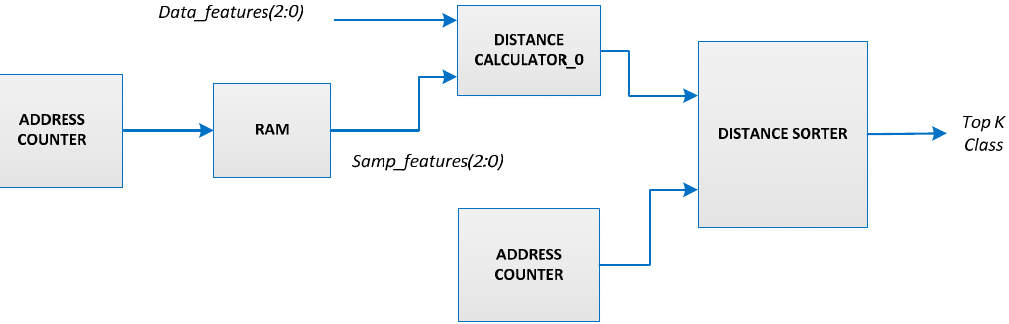
Figure 6 . KNN top-level architecture implemented on the proposed system where the Hjorth parameters from EEG input are compared to saved data models and sorted for the maximum likelihood class.